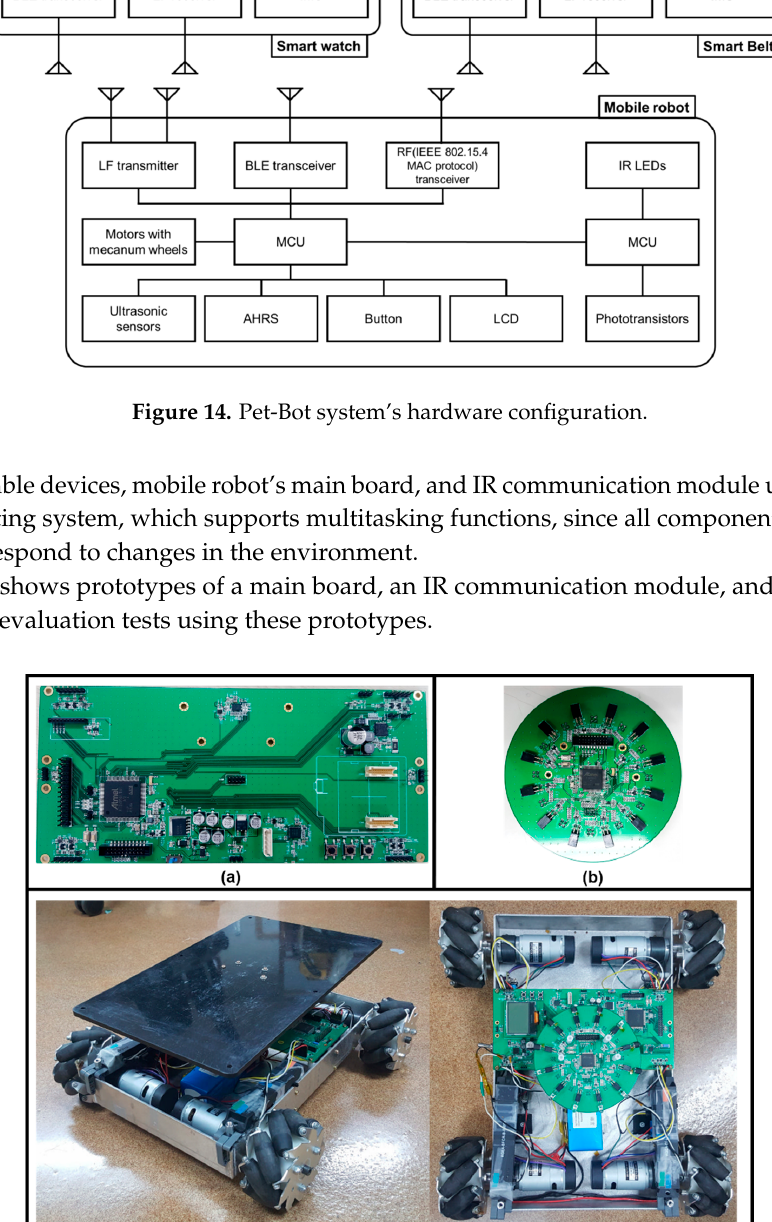
Figure 15. Physical prototypes: ( a ) main board; ( b ) IR communication module; and ( c ) mobile robot.